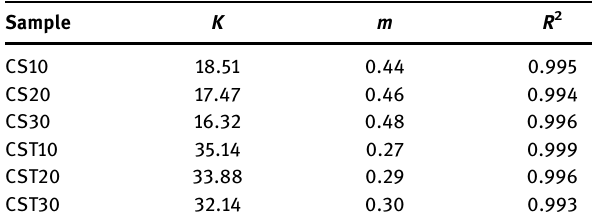
Table 4: Drug ( PI ) release parameters of the nano fi ber mats with and without T80 addition obtained from the Korsmeyer – Peppas